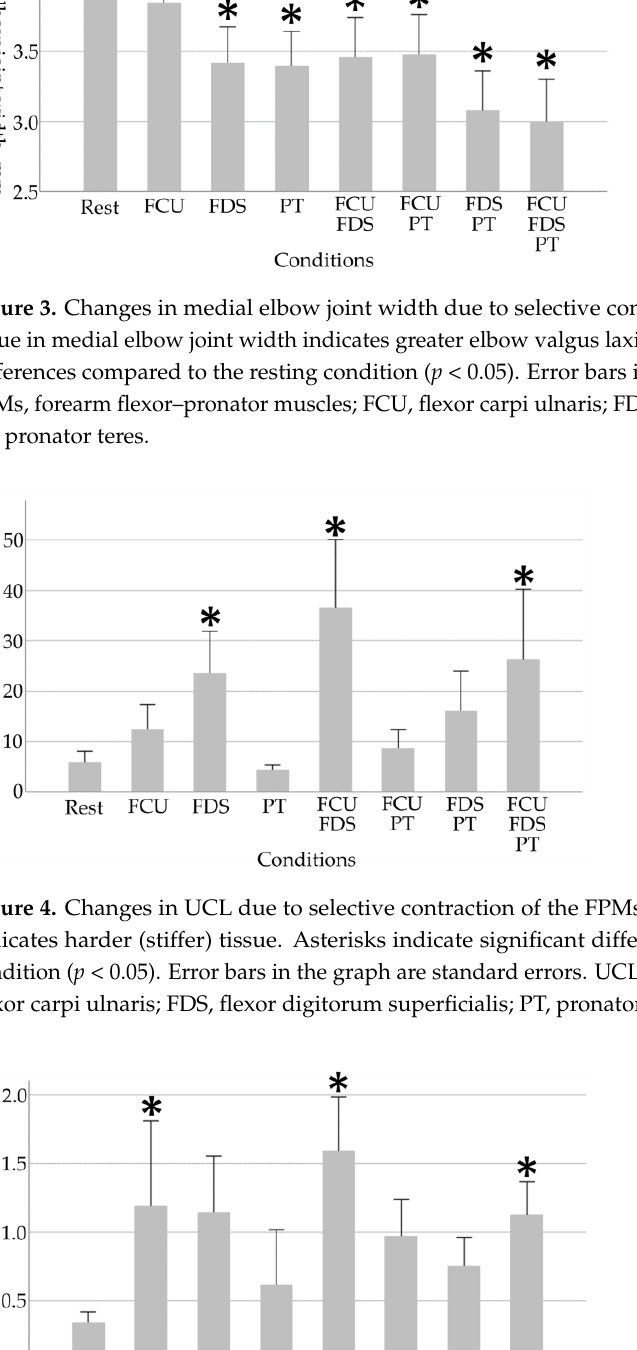
Figure 6. Changes in the ratio of the strain ratio UCL/FPMs due to selective contraction of the FPMs. A smaller value in the ratio of strain ratio UCL/FPMs indicates harder (stiffer) tissue of FPMs rela- tive to that of UCL. Asterisks indicate significant differences compared to the resting condition ( p < 0.05). Error bars in the graph are standard errors. UCL, ulnar collateral ligament; FPMs, forearm flexor – pronator muscles; FCU, flexor carpi ulnaris; FDS, flexor digitorum superficialis; PT, pronator teres. 4. Discussion This study investigated (1) changes in the medial elbow stabilizers due to selective contraction of the forearm muscles, and (2) what selective contraction of the forearm mus- cles makes the FPMs harder relative to the UCL. Although medial elbow joint width was little changed by FCU contraction alone, it was significantly decreased (i.e., increase sta- bilization of the medial elbow joint) during activation of FDS and PT alone and when combined. Therefore, it was suggested that FCU contributes little to the stabilization of the medial elbow joint, while FDS and PT greatly contribute to that. From the above, it was suggested that muscle strengthening of the entire FPMs (especially FDS and PT) may be effective for stabilizing the medial elbow joint because the more muscles recruited, the more the medial elbow joint width decreased. The present study ’ s results that contraction of the FPMs decreases the medial elbow joint width are similar to previous studies [20,22,30]. New findings from this study are the different stabilizing effects of various se- lective contractions of the forearm muscles against elbow valgus load. With regard to the effect of contraction of various forearm muscles against elbow valgus load, the hardness of the UCL was significantly greater during tasks involving FDS contraction. On the other hand, the hardness of the FPMs showed little change during PT